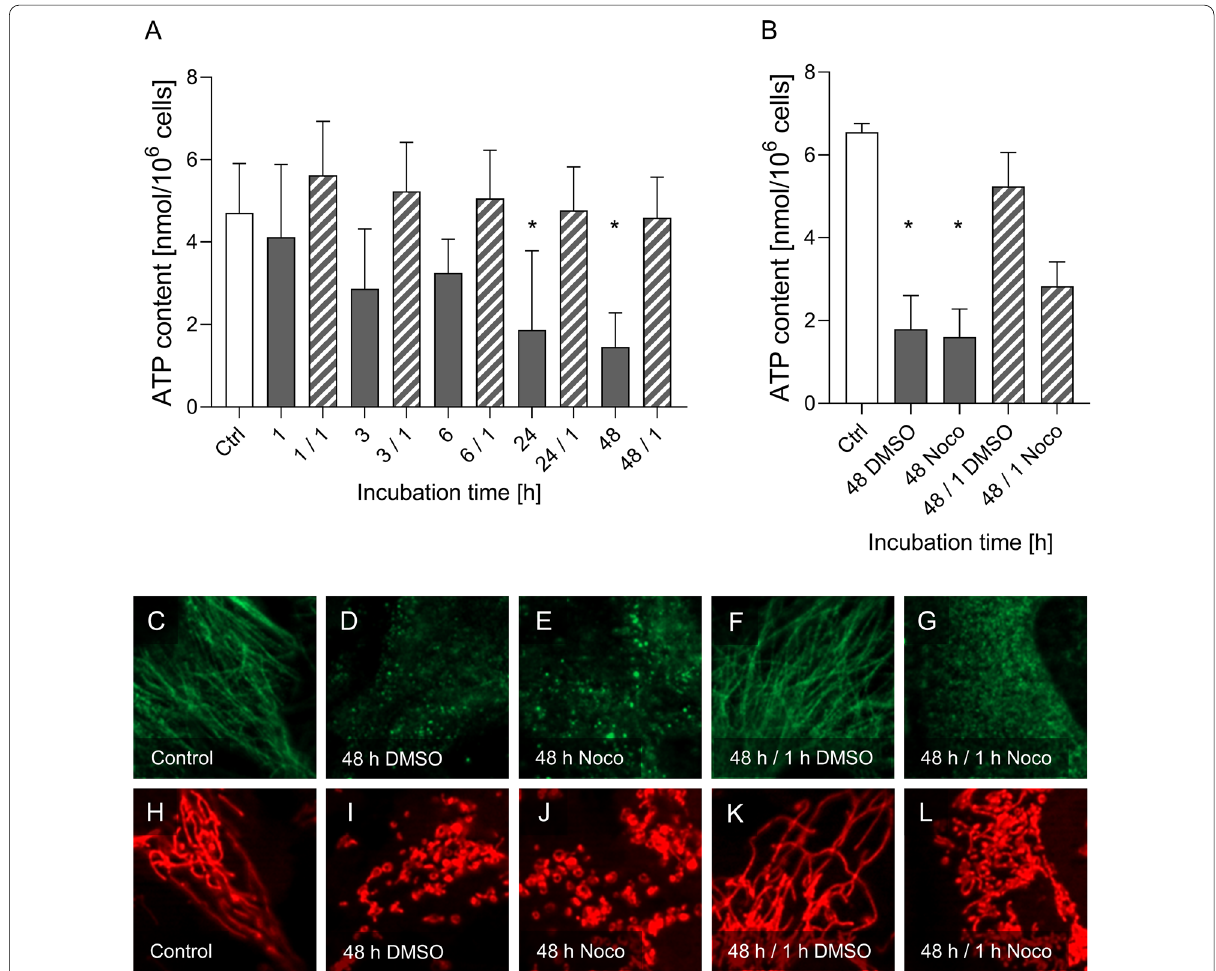
Fig. 10 Cellular ATP content during cold incubation and rewarming. A Aortic endothelial cells (control, ctrl, open bar) were exposed to 4 °C for 1 h, 3 h, 6 h, 24 h and 48 h (grey bars) and rewarmed for 1 h at 37 °C (hatched bars; e.g. 48/1). B Additionally, ATP content was measured after 48 h at 4 °C and rewarming for 1 h at 37 °C with and without the tubulin polymerization inhibitor nocodazole (Noco; added 18 h before rewarming). ATP was measured in cell lysates with a bioluminescence assay kit. Means mitochondria (red; H – L ) are shown (MitoTracker Red: λ exc. figures of n 4 experiments. * Significant difference to the control (p =